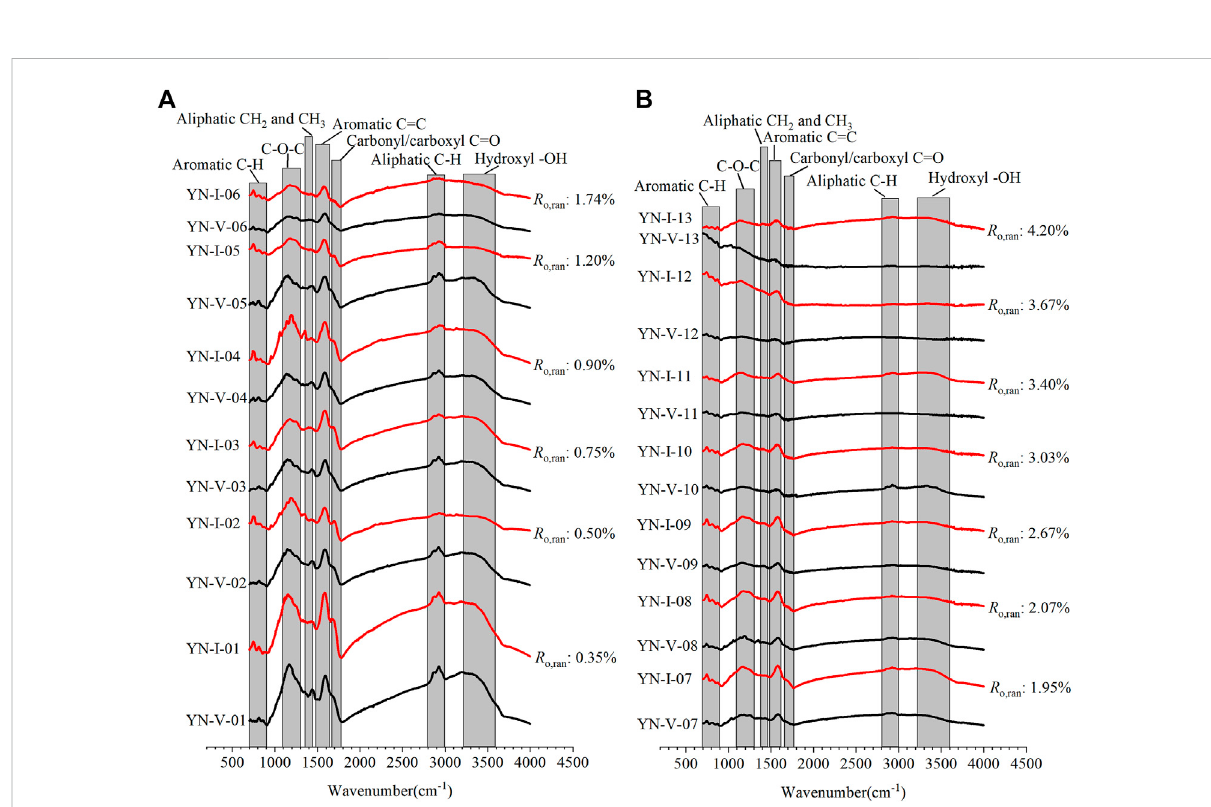
FIGURE 5 FTIR spectrums of thermally simulated vitrinite (A) and inertinite (B) samples.